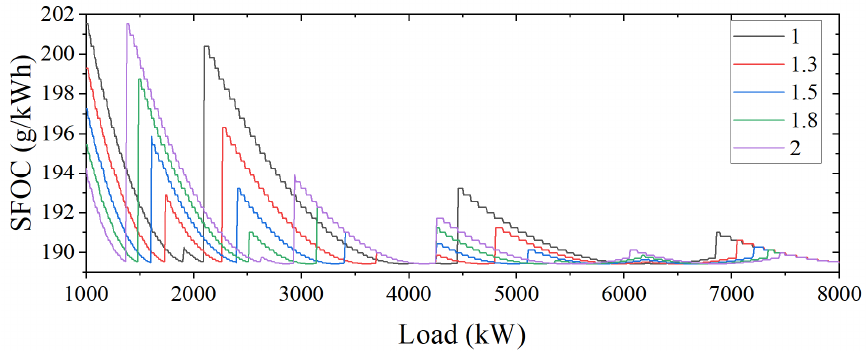
Figure 7. Efficiency change according to 𝐺𝐶𝐼 (cid:3029) value.